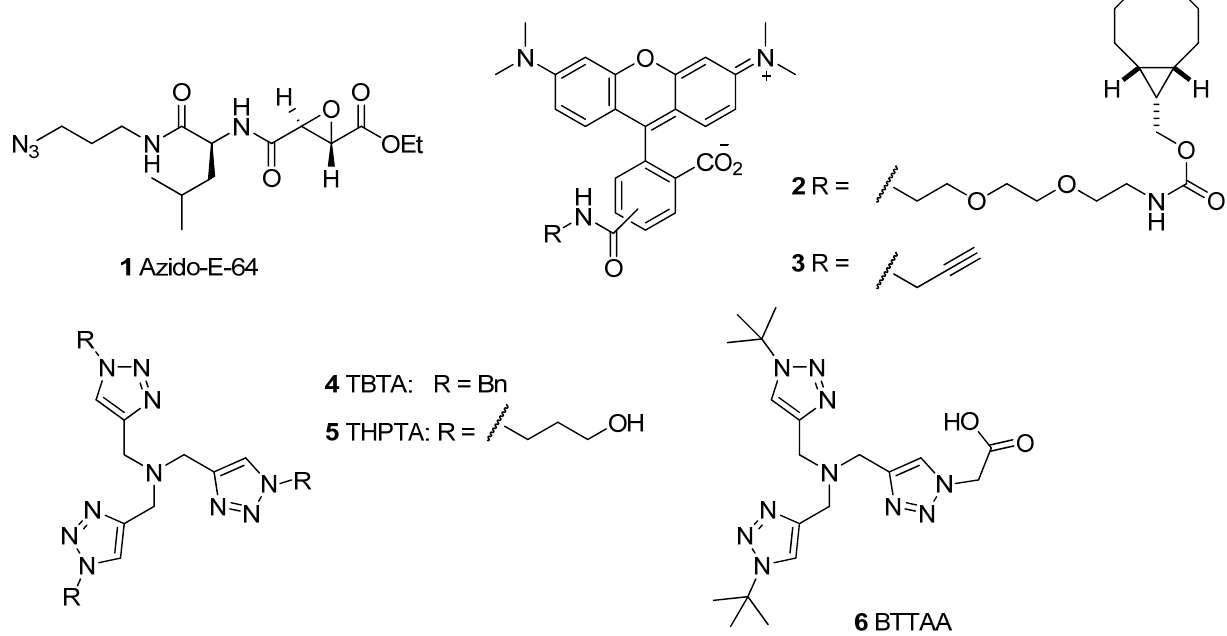
Figure 2. The molecules used in this study: the cell permeable ABP azido-E-64 ( 1 ), two alkyne tags for click chemistry ( 2 and 3 ), and three ligands for Cu(I)-catalyzed click